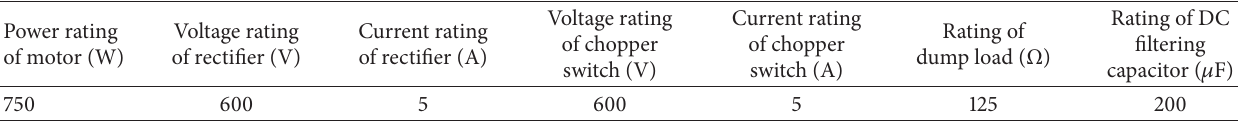
Table 2: Ratings of the components of proposed